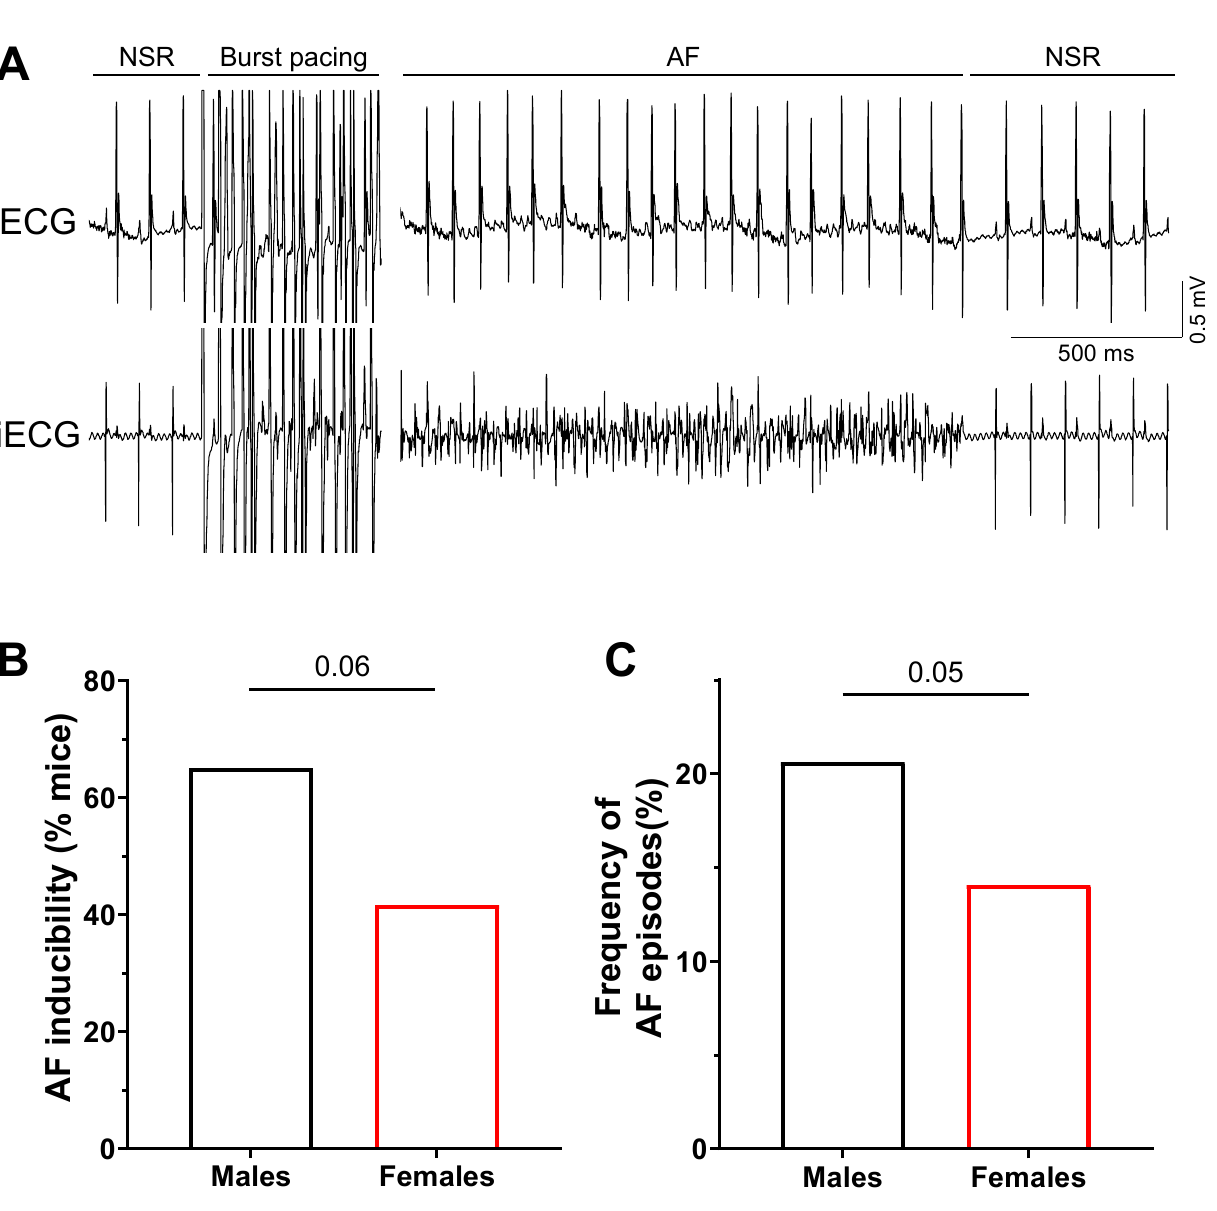
Figure 1. Higher susceptibility to AF in males in response to EPS. ( A ) Typical recording of a lead I surface ECG with simultaneous intracardiac ECG (iECG) during a sequence of normal sinus rhythm (NSR), burst pacing, sustained atrial fibrillation (AF), and recovery to normal sinus rhythm. The burst pacing was cropped lengthwise for the purpose of this example. ( B ) Males developed more AF in response to the burst pacing protocol, presented as the percentage of mice who developed at least one sustained AF (M: 65%, 13/20; F: 42%, 10/24; p = 0.06, one-sided chi-squared test). ( C ) Frequency of AF episodes, as the percentage of AF episodes induced out of the total number of simulations (8 per animal), was higher in males (M: 20%, 33/160; F: 14%, 27/192; p = 0.05, one-sided chi-square test).